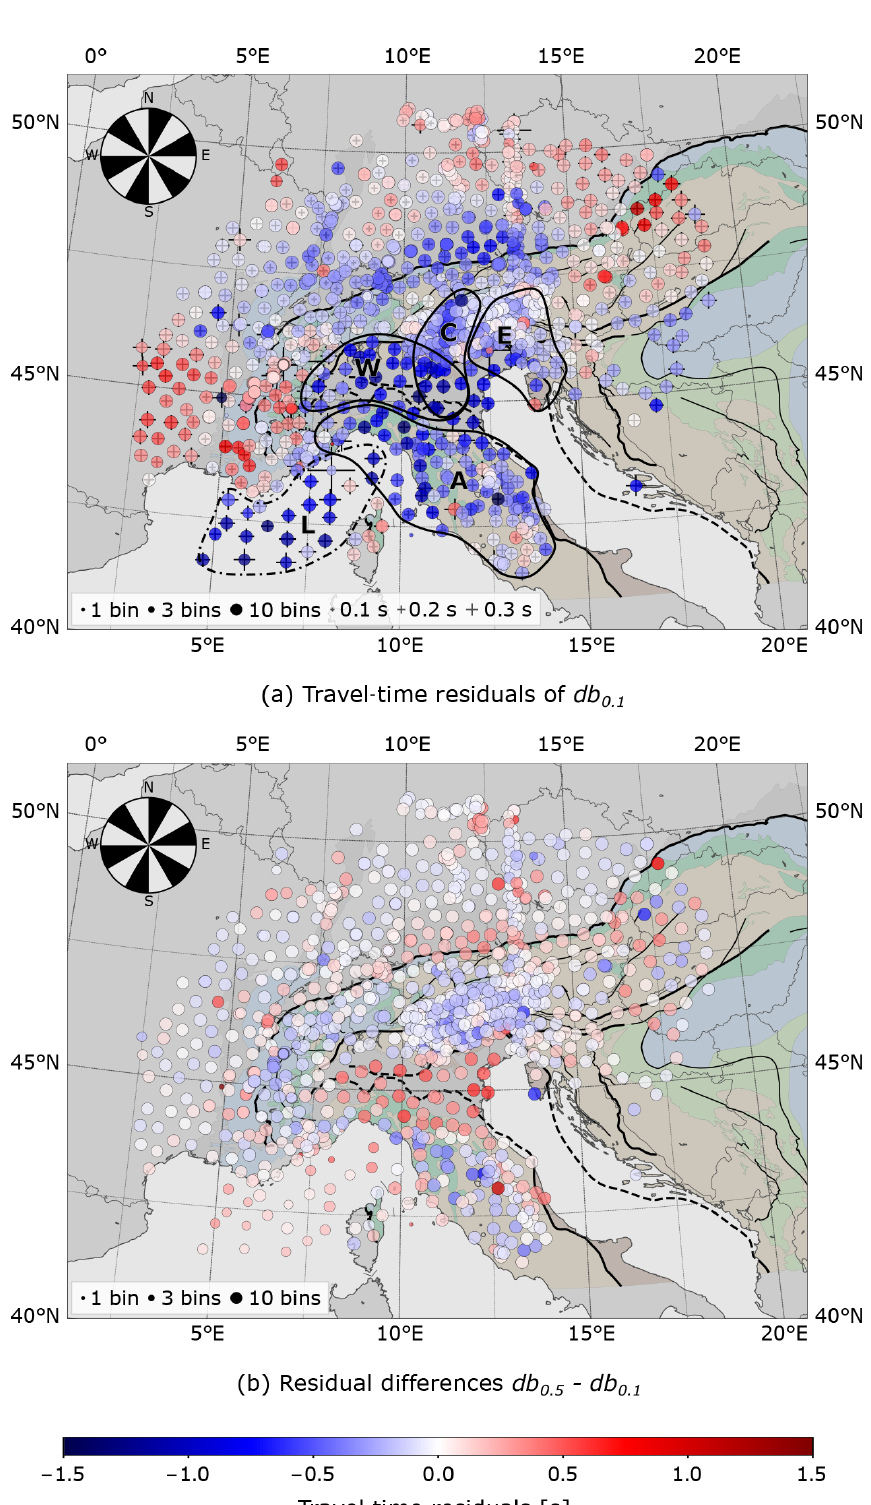
Figure 12. (a) Stacked travel-time residuals for 30 ◦ bins from all directions for db 0 . 1 similar to Fig. 10. Patterns look similar in most areas to the one for the high-frequency dataset at first glance, except for weaker residual amplitudes. (b) Differences between stacked residuals of high- and low-frequency datasets show areas with positive sign (e.g. Po plain), or negative sign (e.g. Apennines, Alpine arc). Proportion of pick differences (same ray available in each dataset) to total number of picks in db 0 . 5 is 96%.